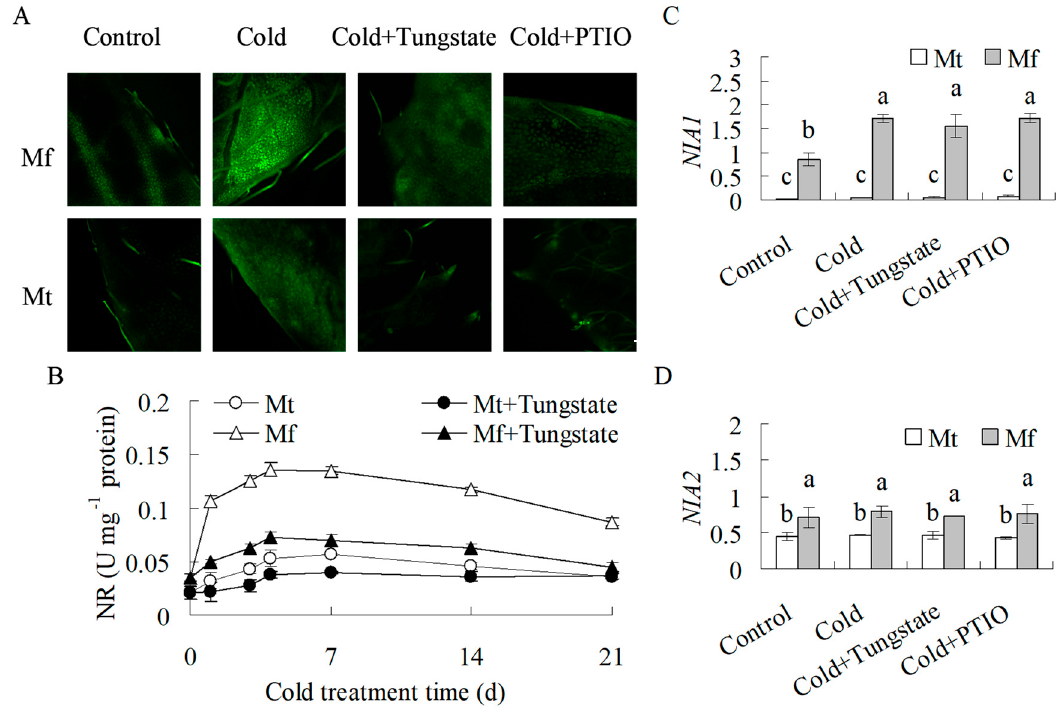
Figure 4. Analysis of nitric oxide (NO) production (a), nitrate reductase (NR) activity, and NIA1 and NIA2 transcripts in response to cold treatment in M. falcata (Mf) in comparison to M. truncatula (Mt). Ten-week-old M. falcata and M. truncatula cv. A17 plants were irrigated with 15 mL of 1 mM tungstate or 100 µ M 2-phenyl-4, 4, 5, 5-tetramethylimidazoline-1-oxyl 3-oxide (PTIO) solution or H 2 O as a control, followed by exposure to 5 ◦ C in a growth chamber. After 24 h of cold treatment, NO production was detected using the NO specific fluorescent probe, DAF-FM-DA ( A ), and NIA1 and NIA2 transcripts were detected using quantitative RT-PCR. Actin was used as a reference gene to calculate the relative expression ( C , D ). Scan bar is 500 µ m. NR activity was detected as indicated in the figure ( B ). Means of three replicates and standard errors are presented; the same letter above the column indicates no significant difference within each day at p <